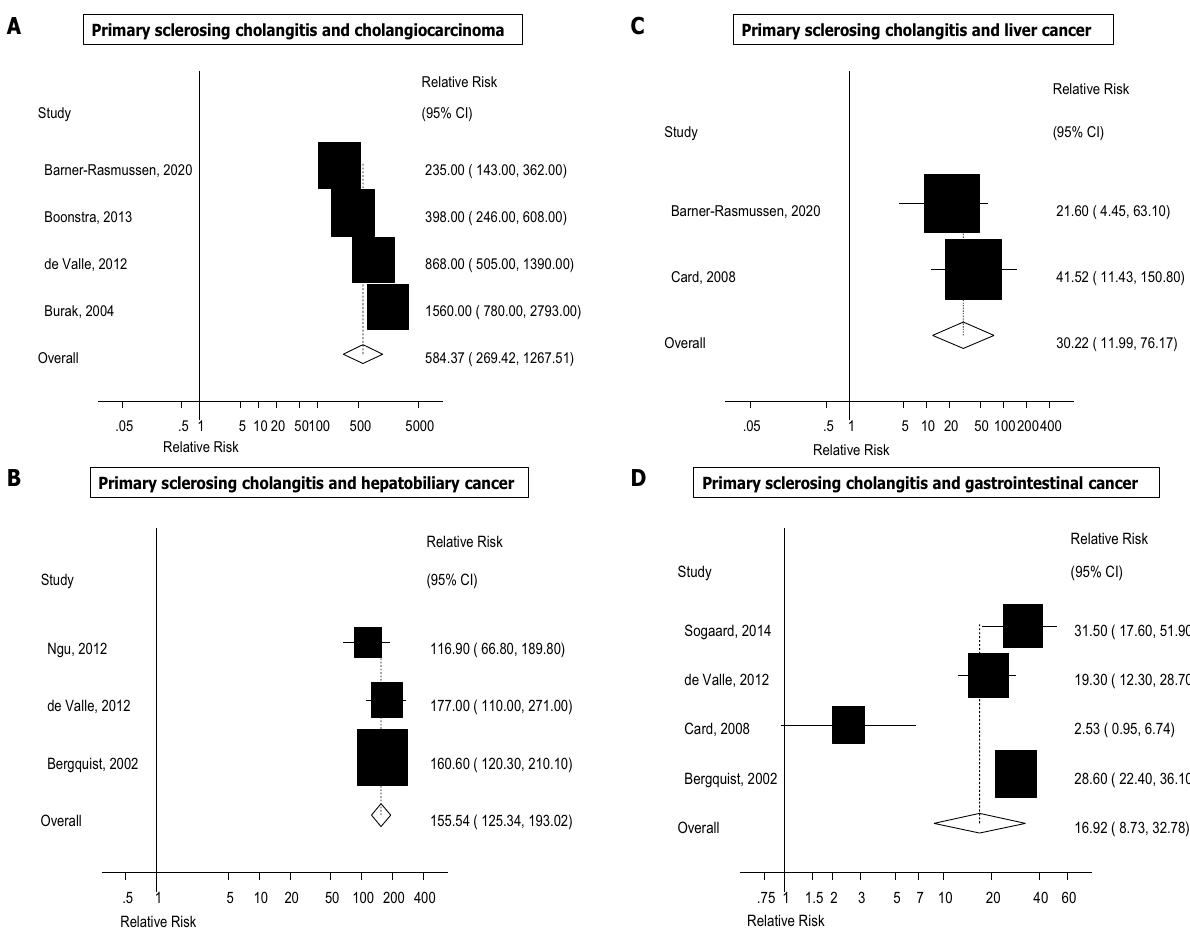
Figure 3. Primary sclerosing cholangitis and cholangiocarcinoma, hepatobiliary cancer, liver cancer and gastrointestinal cancer